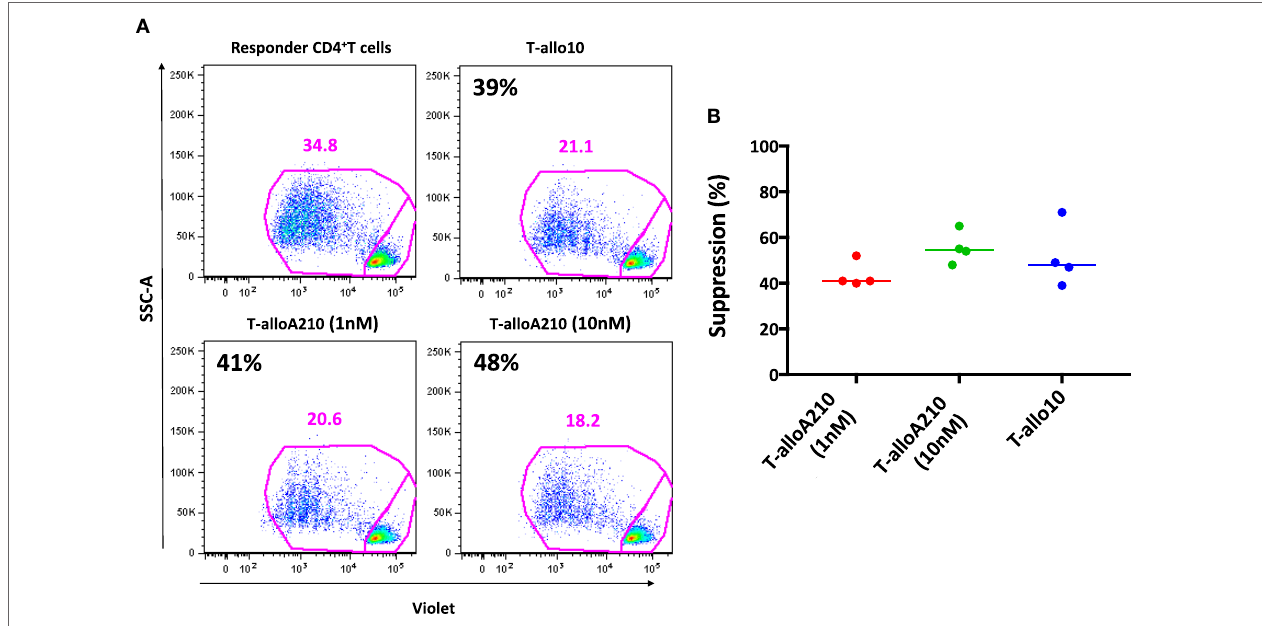
FigUre 4 | T-alloA210 cells suppress proliferation of autologous CD4 + T cells. DC differentiated in the presence of APVO210 (DC-A210), DC-10, and mature DC (mDC) were incubated for 10 days with allogenic T cells. Suppressor T cells (“S”) cultured with allogenic DC-A210 + APVO210 (T-alloA210: 1 or 10 nM) and DC-10 + IL-10 (T-allo10; n = 4) were tested for their ability to suppress proliferation of autologous responder CD4 + T (“R”) cells in response to allogenic mDC stimulation. Responder T cells were stained with Violet dye, and their proliferation was evaluated by flow cytometry. Percentage of suppression was calculated using the formula “(% proliferation R − % proliferation R with S)/% proliferation R.” (a) Data of one representative donor are shown; percentage of suppression is indicated in black. (B) Plot showing cumulative data of suppression. Median values are indicated, each dot represents a single donor, and lines indicate median values. Paired t -tests with Bonferroni correction were performed for statistical